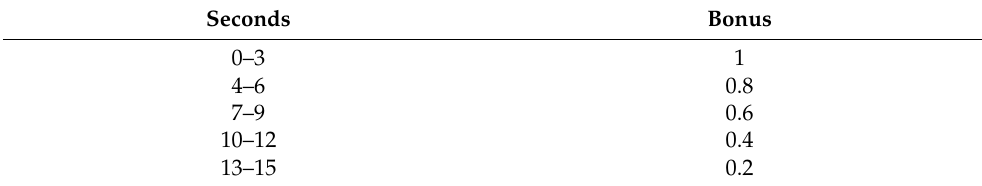
Table 1. The evaluation of the response time in situations 1–6 and